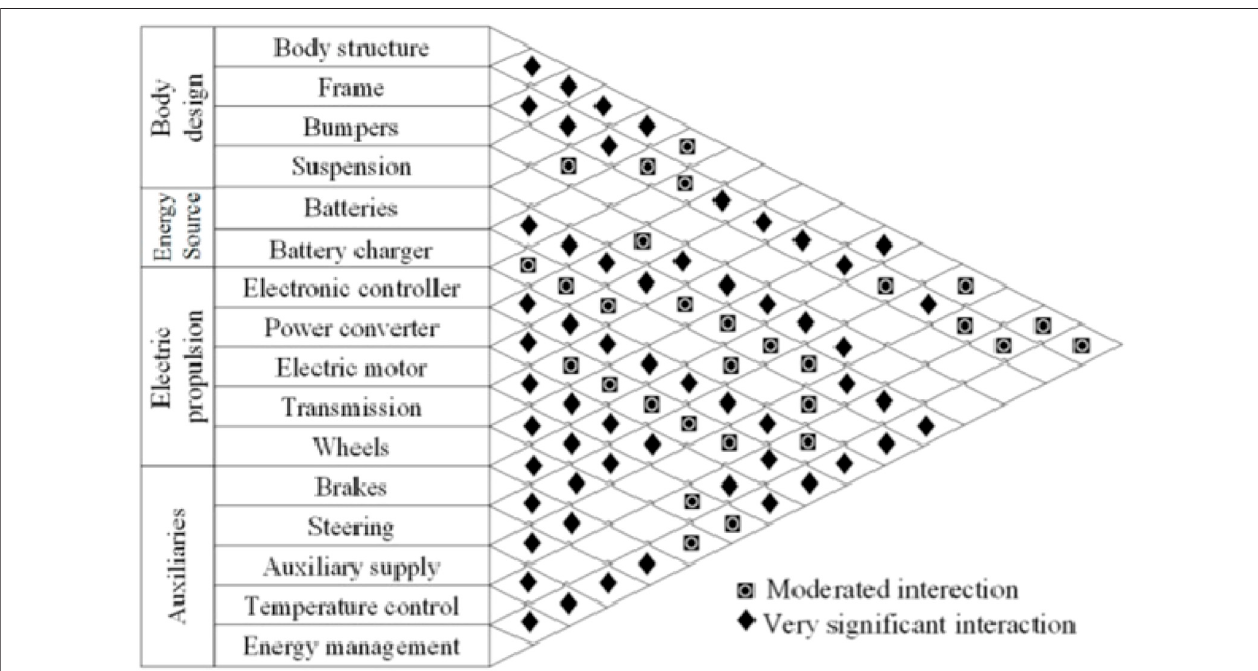
FIGURE 1 | Major EV Sub-systems and their Interactions. Data from (Andwari et al., 2015).